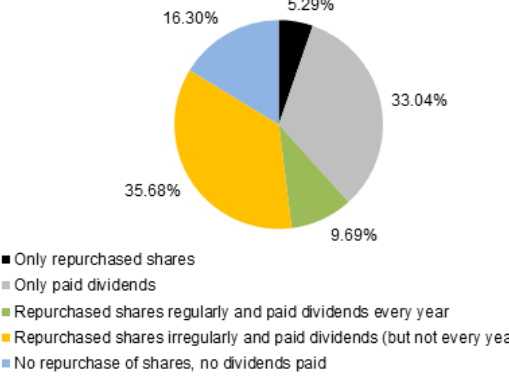
Figure 5: Payout behaviour based on number of companies